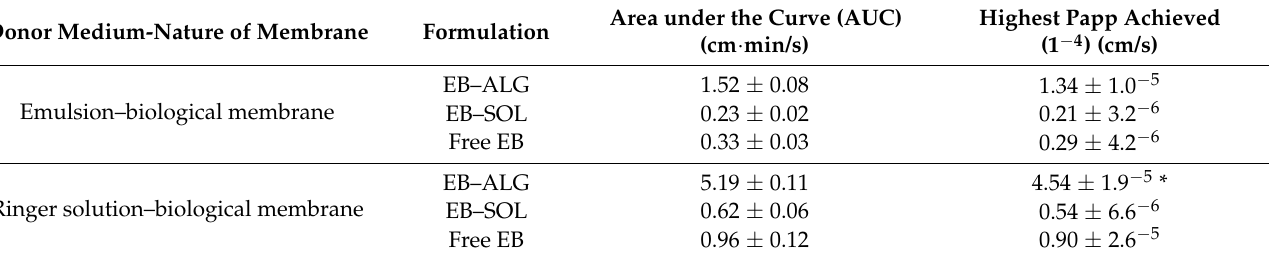
Table 2. Apparent permeability results in biological membrane.